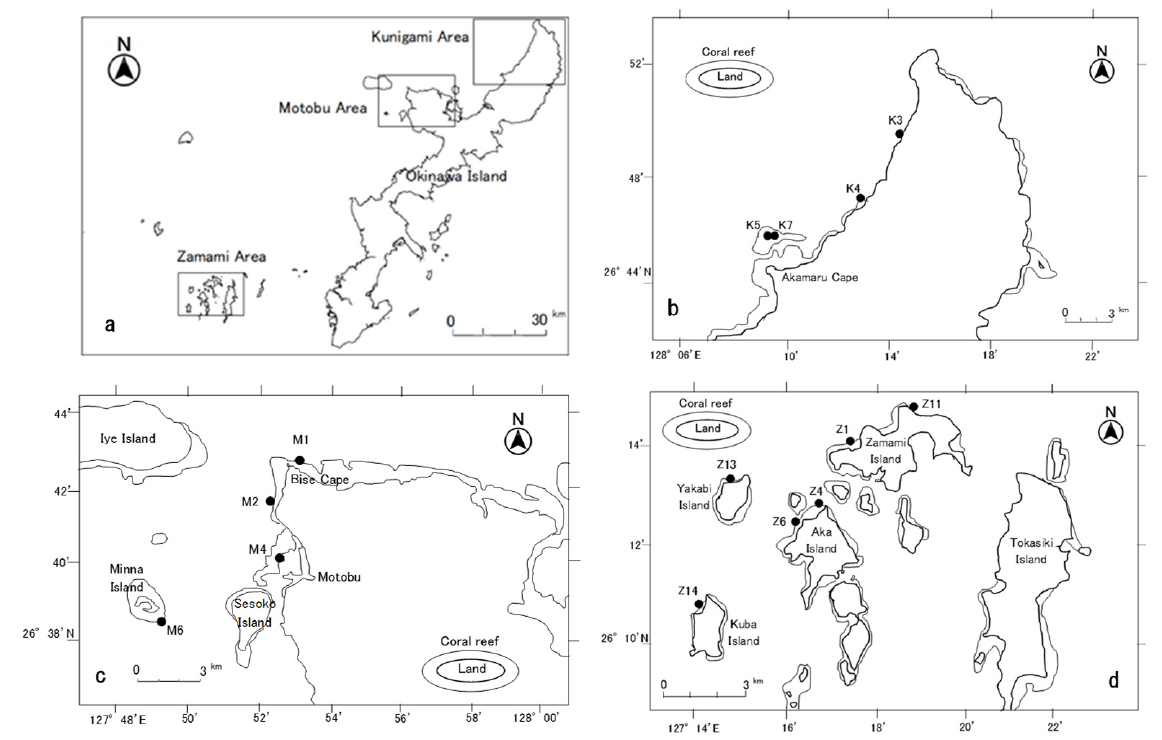
Figure 2. Study sites. ( a ) Overview; ( b ) Kunigami area; ( c ) Motobu area; ( d ) Zamami area.